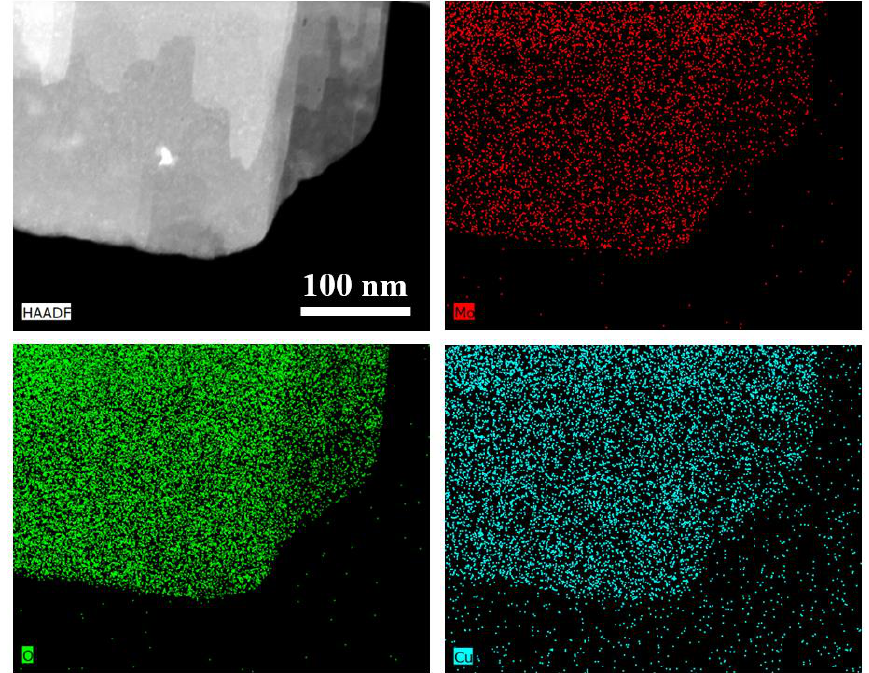
Figure 3. The elemental mapping images of Cu doped MoO 3 nanosheet.